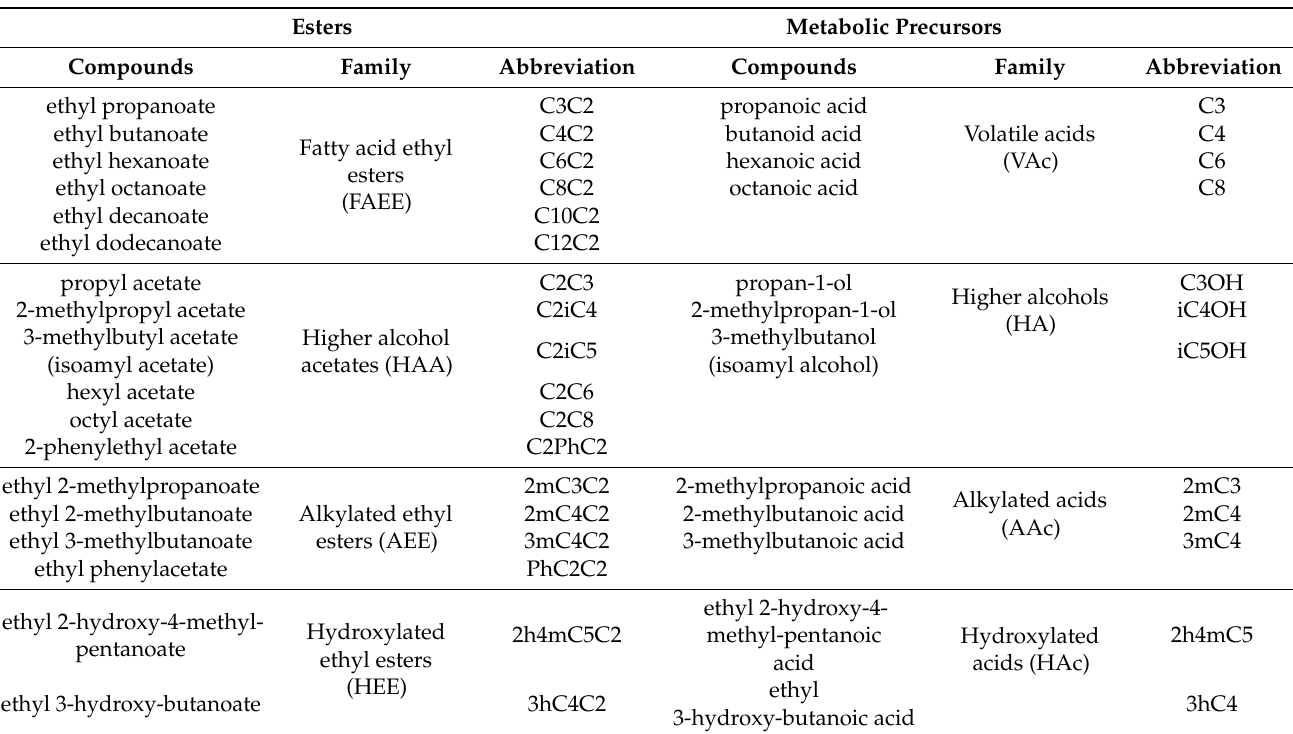
Table 1. Chemical compounds assayed by